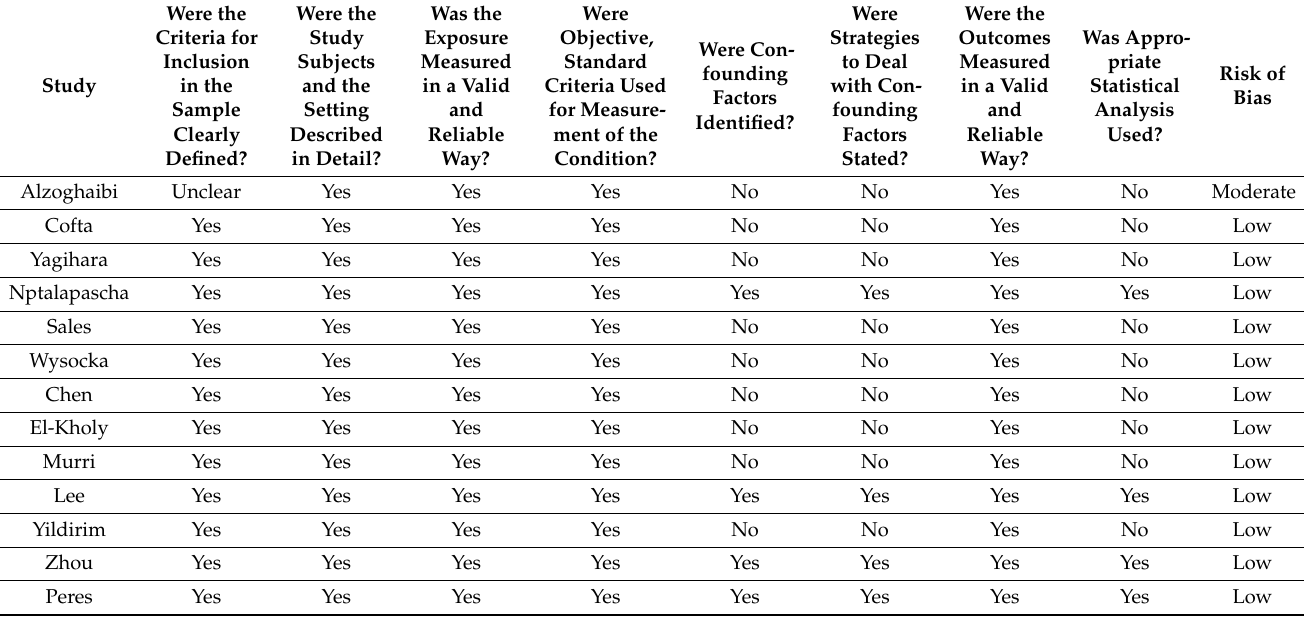
Table 2. The Joanna Briggs Institute critical appraisal checklist for analytical cross-sectional